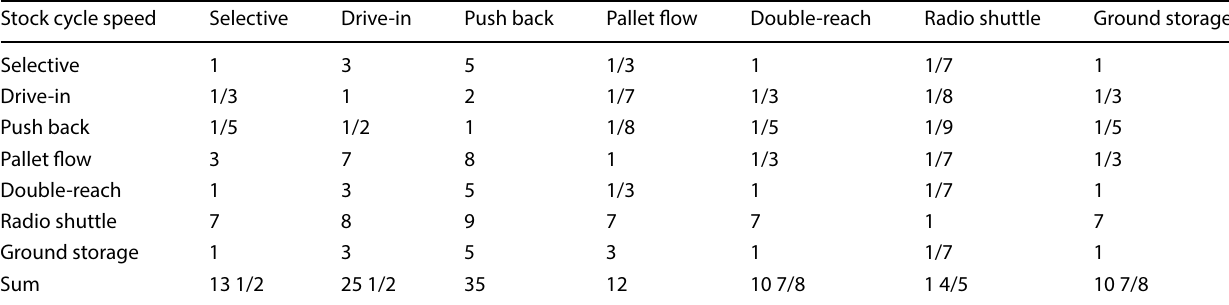
Table 14 Comparison between the alternatives in term of stock cycle speed Stock cycle speed